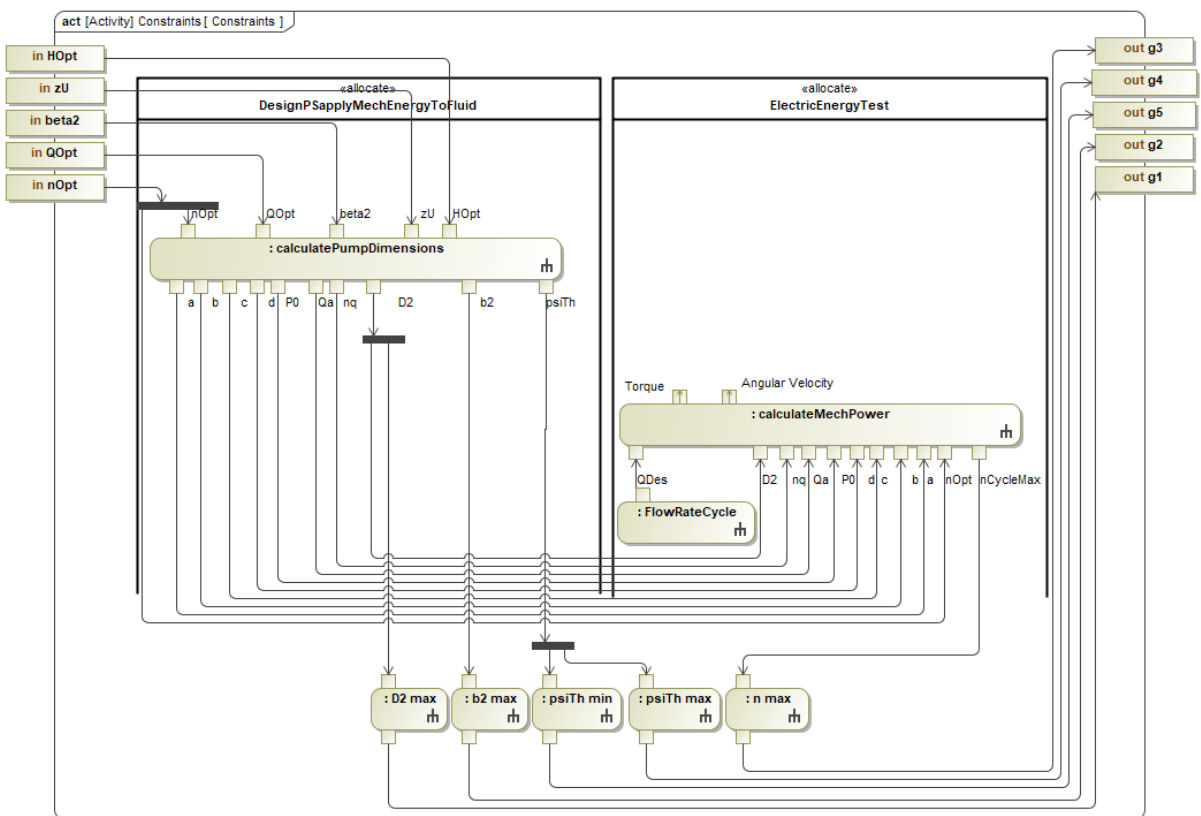
Figure 13. Activity diagram for the constraint calculation.